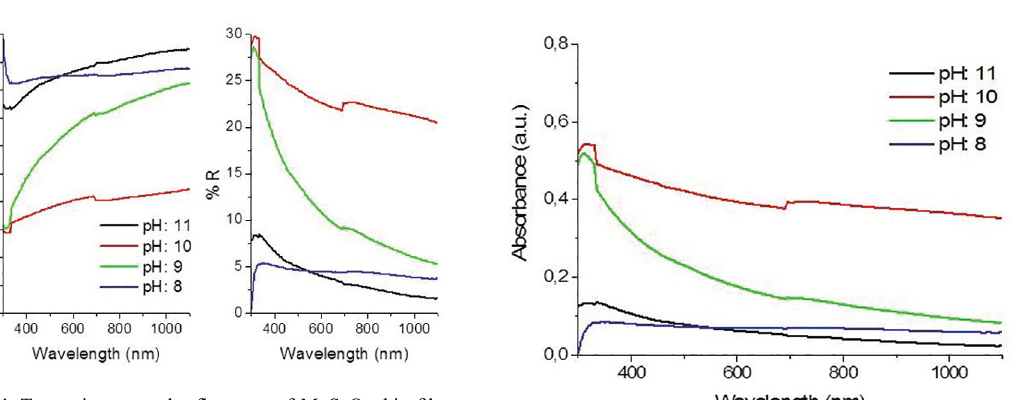
thin films 4 Figure 5. Absorbance of MnSeO pH